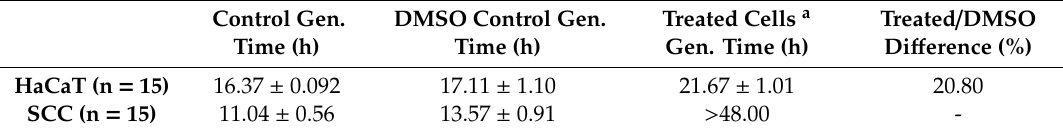
Table 5. The e ff ect of compound 10 on the generation times of the cells. Table 5. The effect of compound 10 on the generation times of the cells.